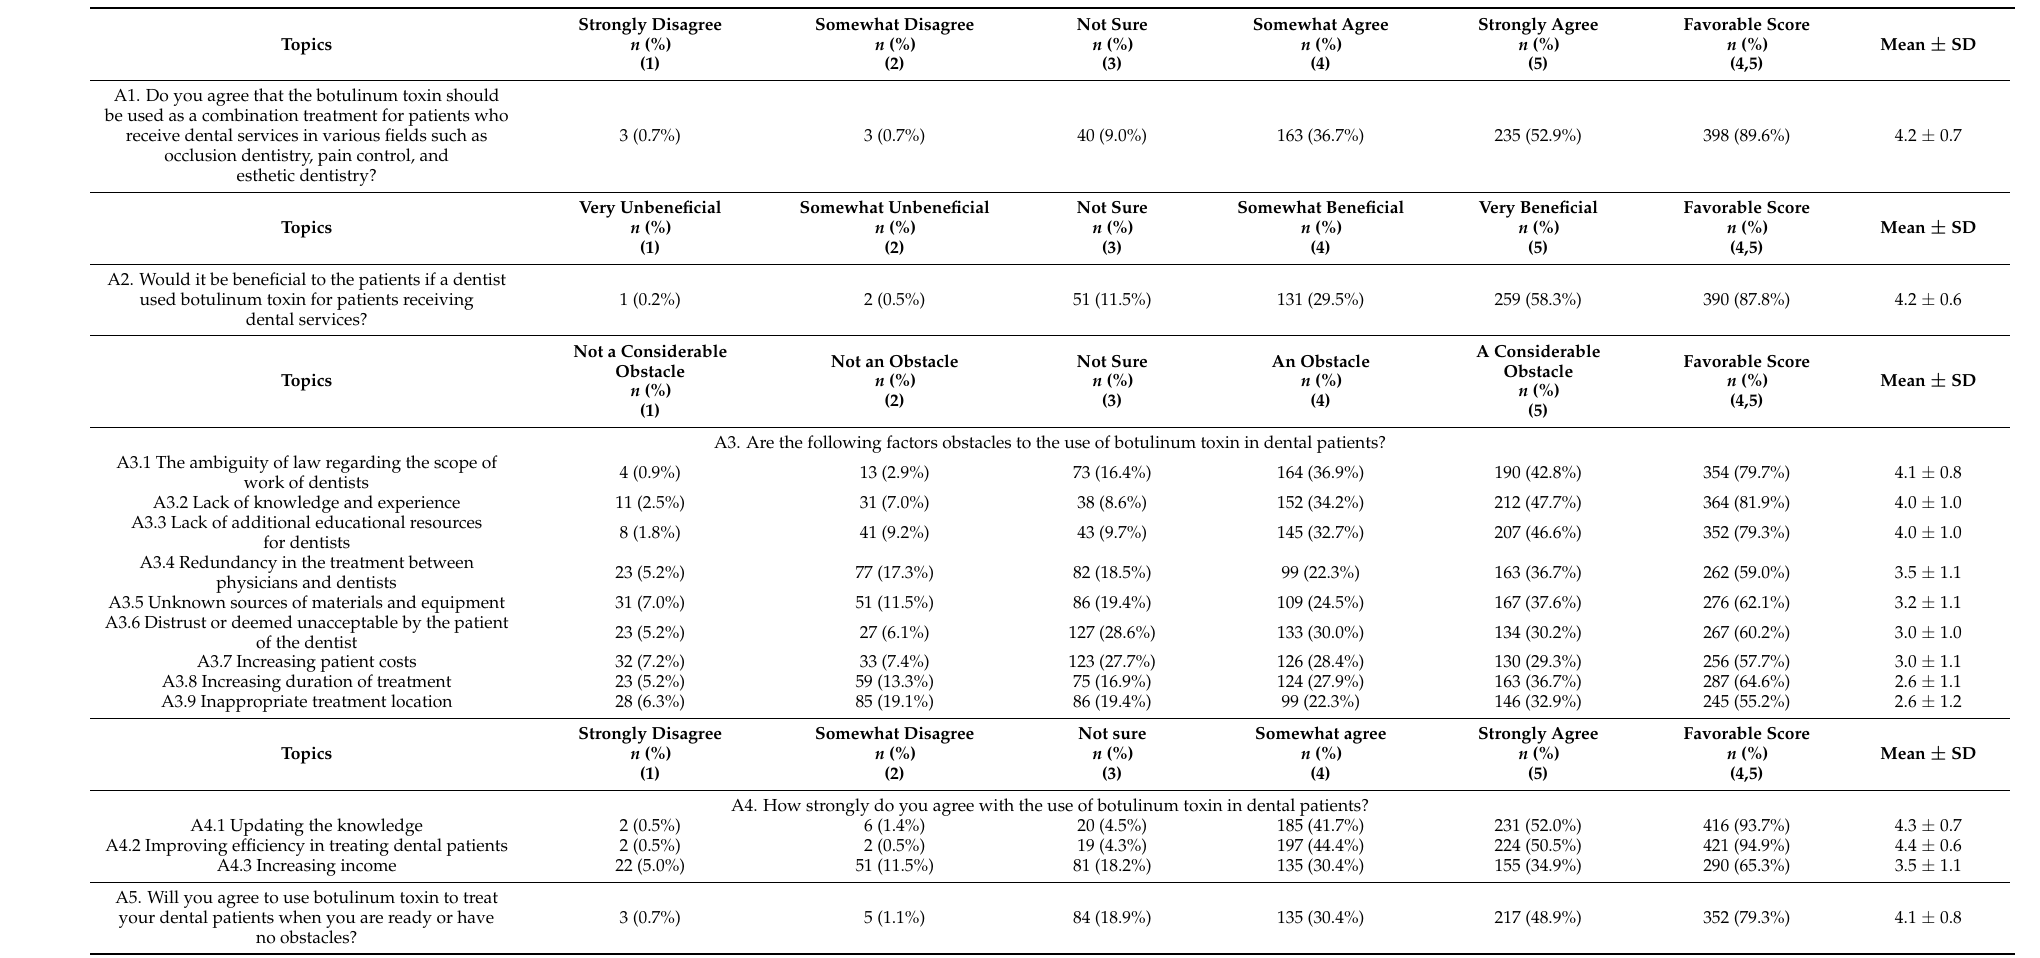
Table 3. The attitude of 444 Thai dental practitioners towards using BTX in